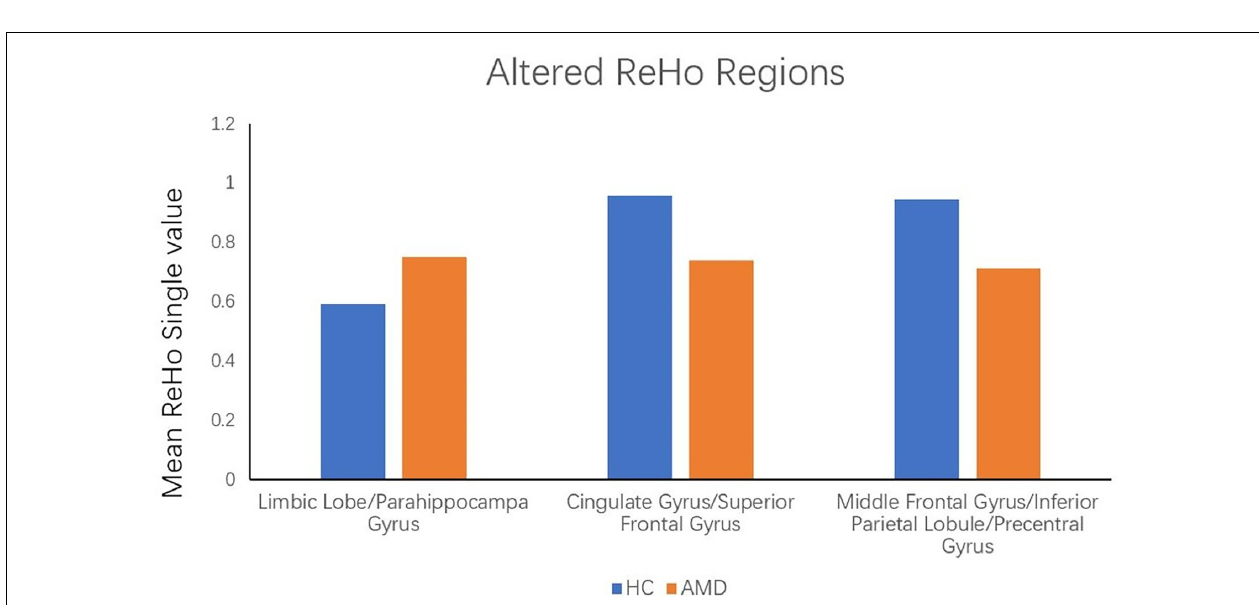
FIGURE 2 | Significant differences in ReHo values between the AMD group and HCs. Blue areas denote significantly reduced ReHo values in the cingulate gyrus, superior frontal gyrus, middle frontal gyrus, inferior parietal lobule, and precentral gyrus, red areas denote significantly increased ReHo values in the limbic lobe and parahippocampal gyrus.